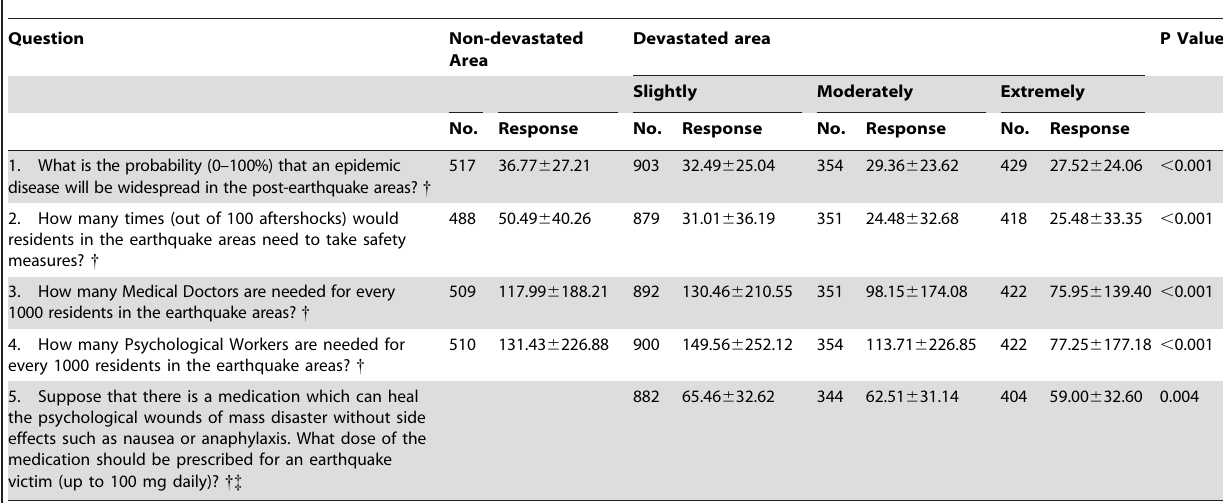
Table 2. The Post-earthquake Concern about Safety and Health Assessed on the Response to the Five Questions.*